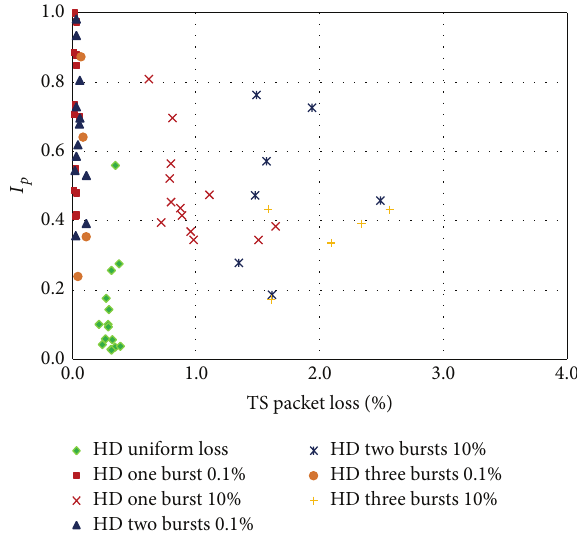
Figure 5: 𝐼 𝑝 versus percentage of TS packet loss for HD resolution.